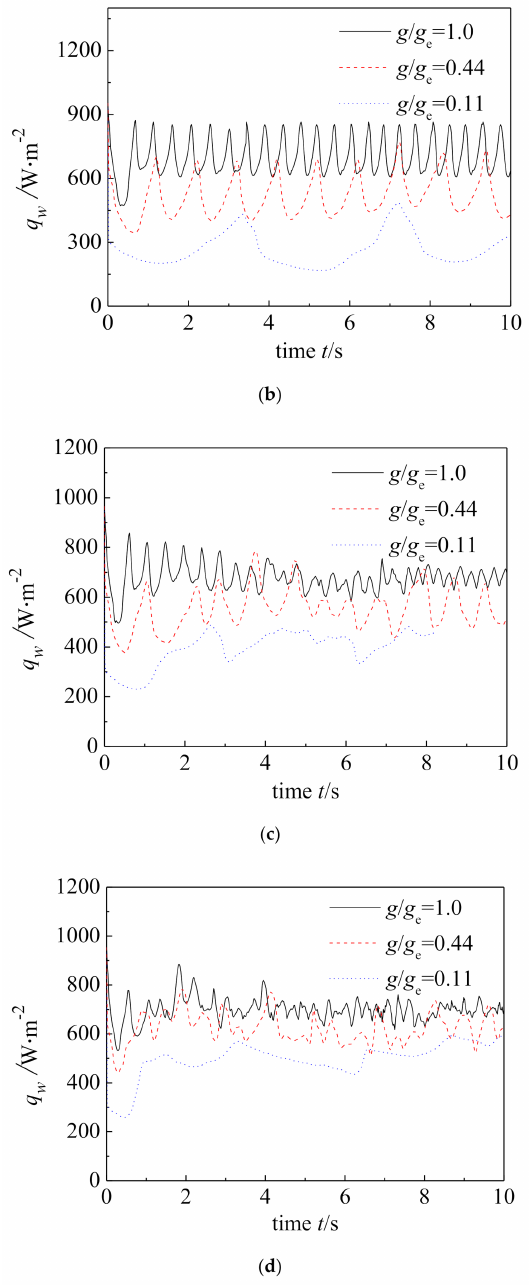
Figure 6. Effect of magnetic field intensity on the variation of the space-averaged heat flux with time.